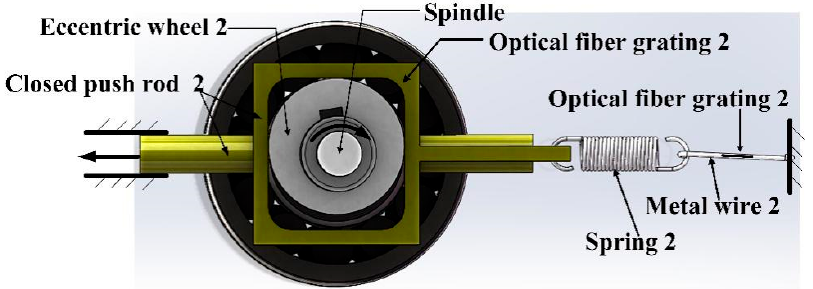
Figure 4. The displacement measurement of eccentric wheel two offset 90° and enclosed push rod two.